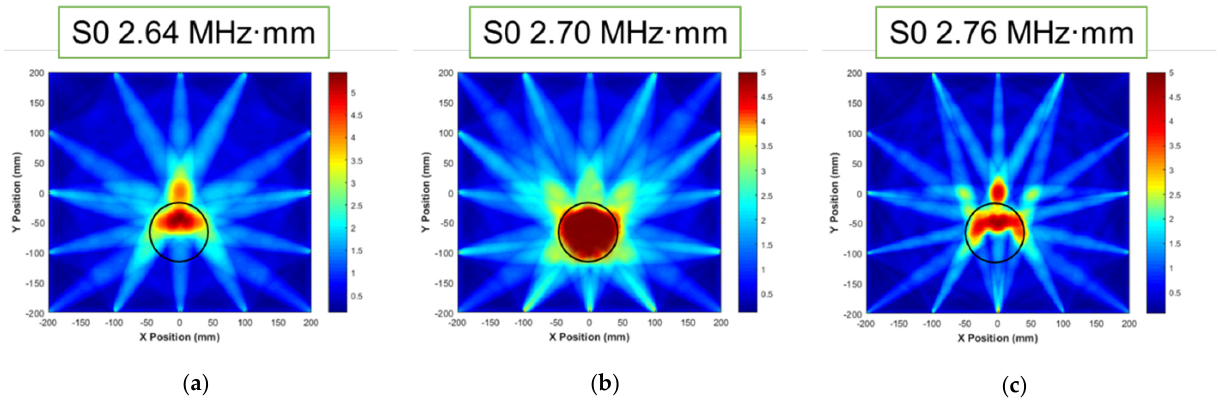
Figure 10. RAPID tomographic images for S0 2.64 to 2.76 MHz·mm: ( a ) S0 2.64 MHz·mm, ( b ) S0 2.70 MHz·mm, and ( c ) S0 2.76 MHz·mm. 2.76 MHz ·